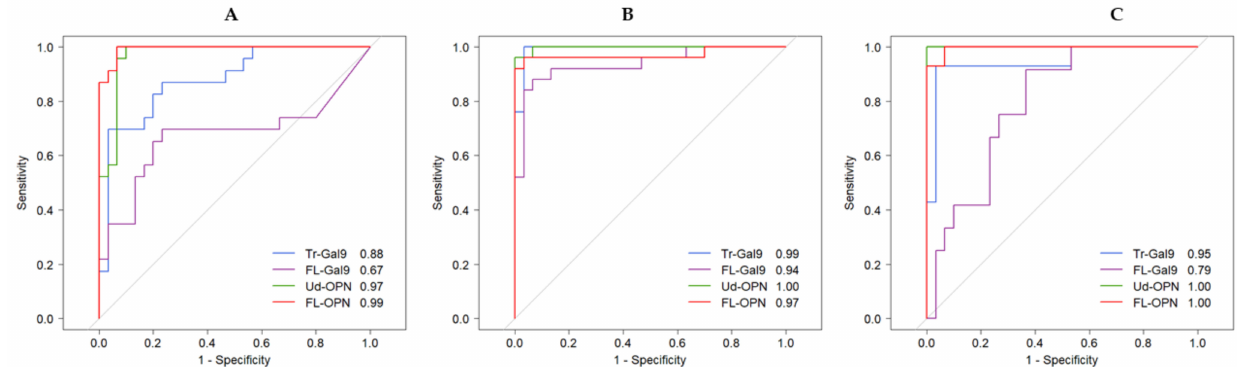
Figure 4. ROC analysis of Gal-9 (FL-Gal9 and Tr-Gal9) and OPN (FL-OPN and Ud-OPN) between the HC and CV groups ( A ), the CP group ( B ) and the ID group ( C ).